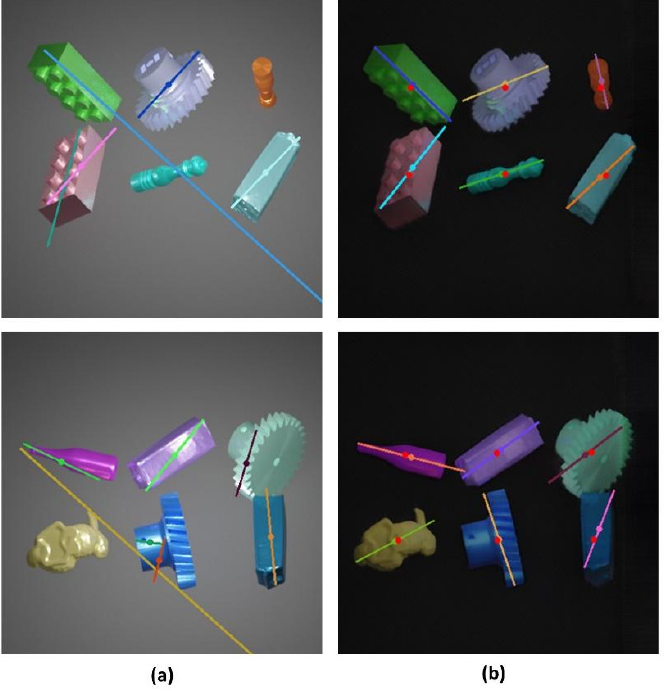
Figure 17. Pose estimation using input images and generated images. ( a ) Input images with specular reflections; ( b ) Output images generated from specular reflection remover of SpecToPoseNet . Table 2. Quantitative metrics for SpecToPoseNet output and non-translated input